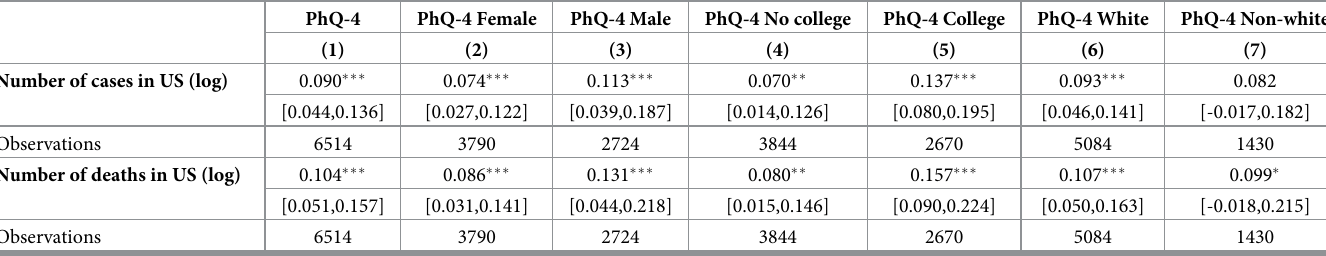
Table 2. Associations with the raising number of Covid-19 cases and deaths in the US on mental health score (PhQ-4).